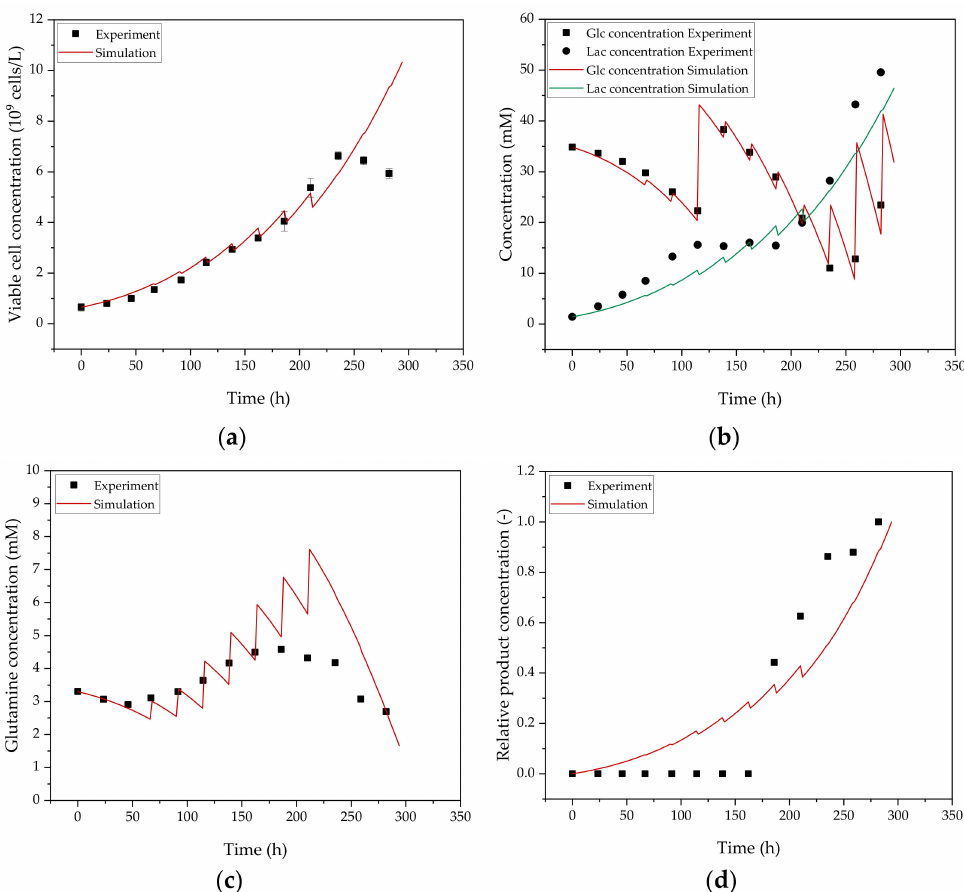
Figure 4. Concentration profiles of viable cell concentration ( a ), glucose ( GLC ) and lactate ( LAC ) concentration ( b ), glutamine concentration ( c ), and relative product concentration ( d ). Experimental results are shown as data points; simulation results are shown as lines. In plot ( d ), experimental data were only available in the last five days of cultivation since the VLP concentration was below the detection limit before